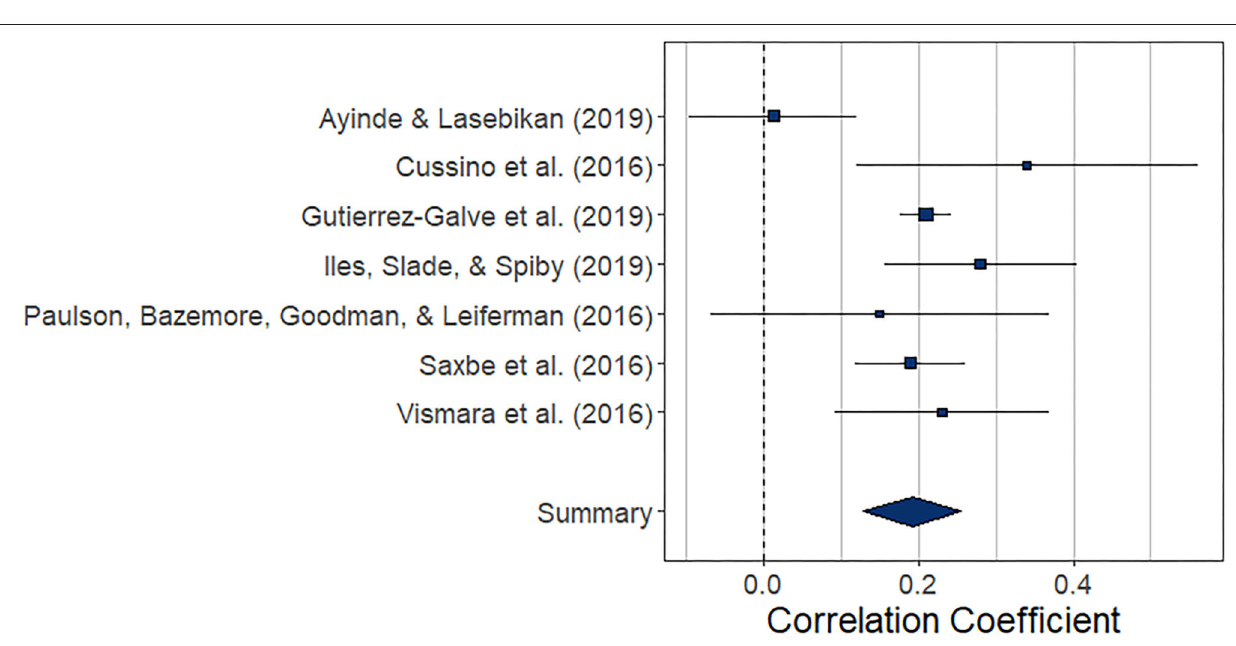
years and may be a factor of interest to consider in future studies on perinatal parental